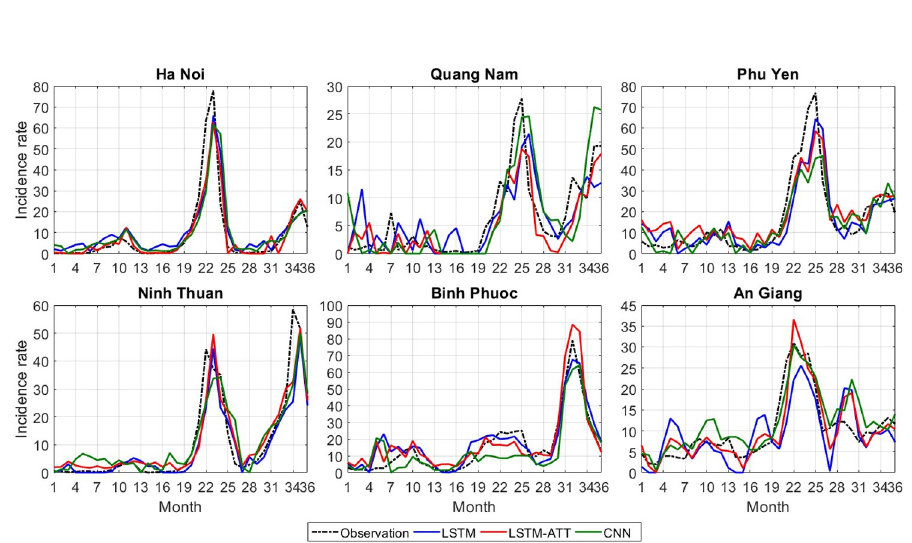
Fig 3. Prediction performances of CNN, LSTM, and LSTM-ATT during the last 36 months in six Vietnamese provinces. Predicted incidence rates per 100,000 population from 2014 to 2016 are shown compared to the observed incidence rates. The closer the predictions are to the observed values, the better the prediction accuracies. CNN = convolutional neural network. LSTM = long short-term memory. LSTM-ATT = attention mechanism- enhanced